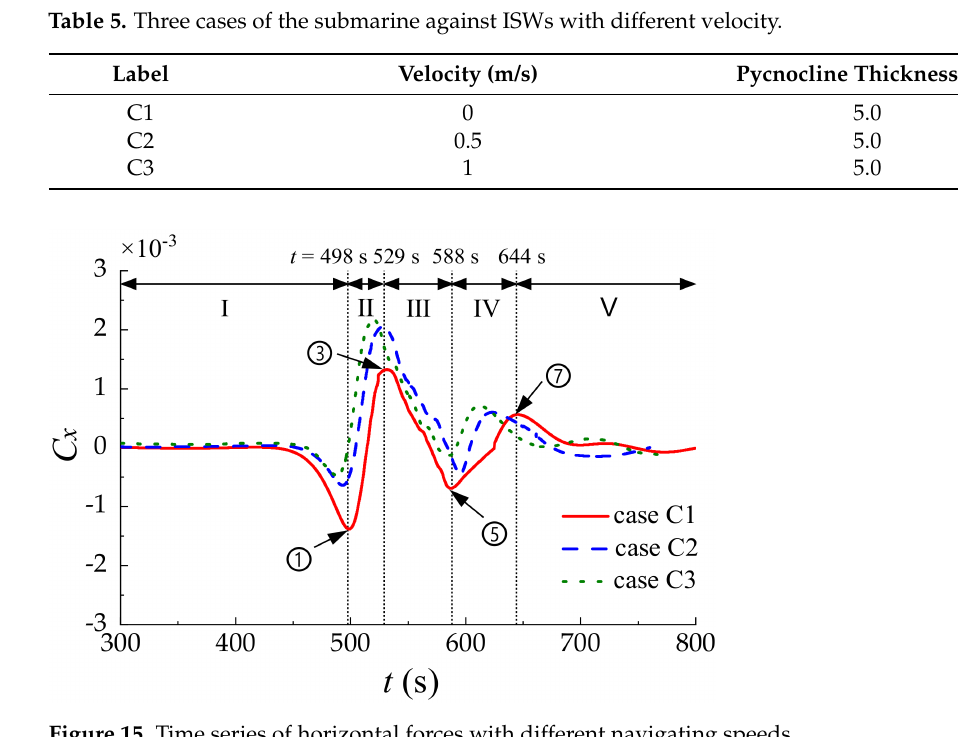
Figure 15. Time series of horizontal forces with different navigating speeds.